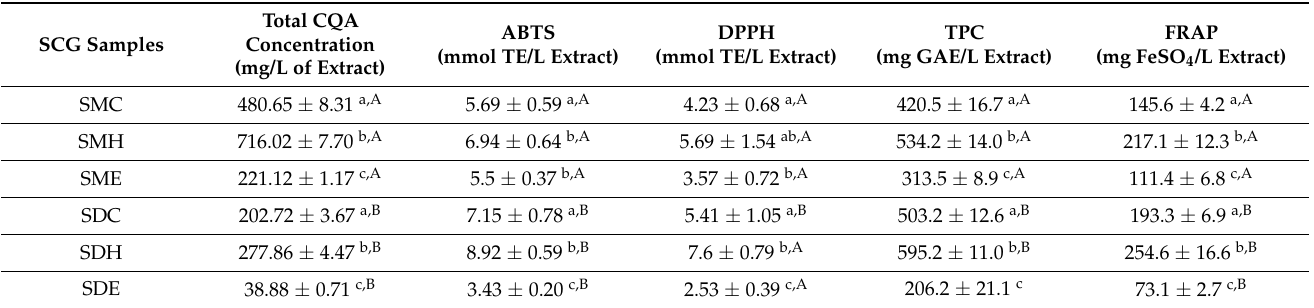
Table 2. Total CQA Concentration and TAC Levels of Six (6) SCG Extracts. Total CQA SCG Samples Concentration (mg/L of Extract)